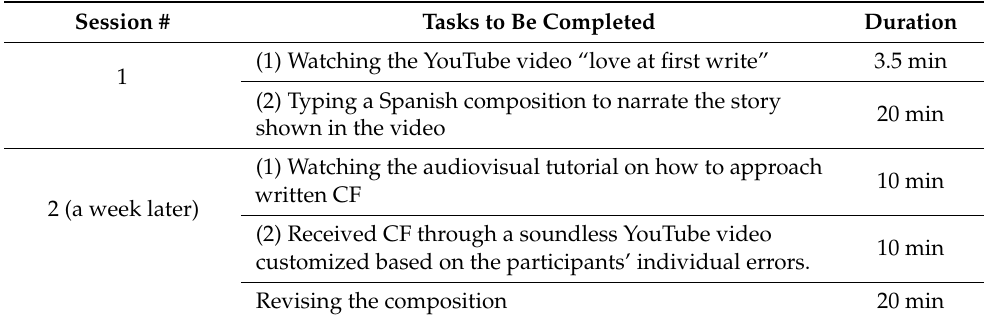
Table 1. Data collection